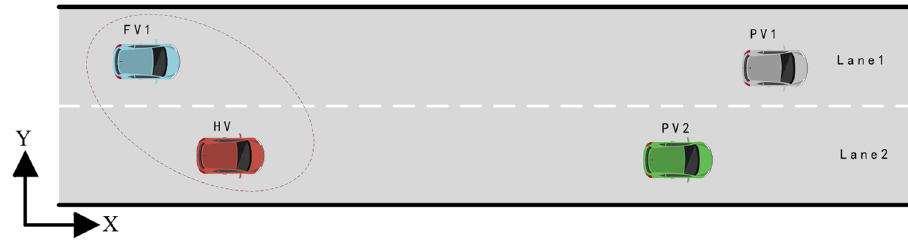
Figure 8. Testing Scenario A.